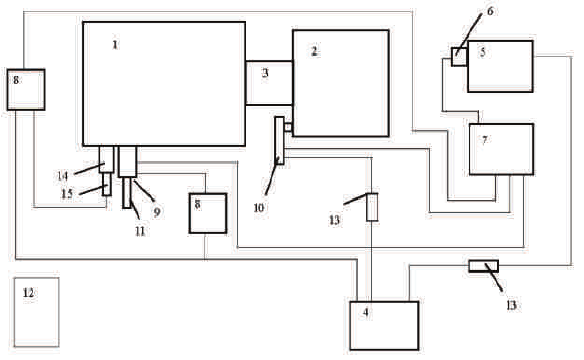
Fig. 2. Measuring circuit of investigations: 1 – internal combustion engine, 2 – generator, 3 – shaft with clutch the permanent clutch, 4 – power sup- ply, 5 – portable computer, 6 – measuring card analog-digital, 8 – signal amplifier, 9 – injection pump, indicators valves, 10 – crankshaft position sensor, 11 – pressure sensor in the injection pump, pressure sensor, 12 – weather monitoring device, 13 – power supply 14–cylinder